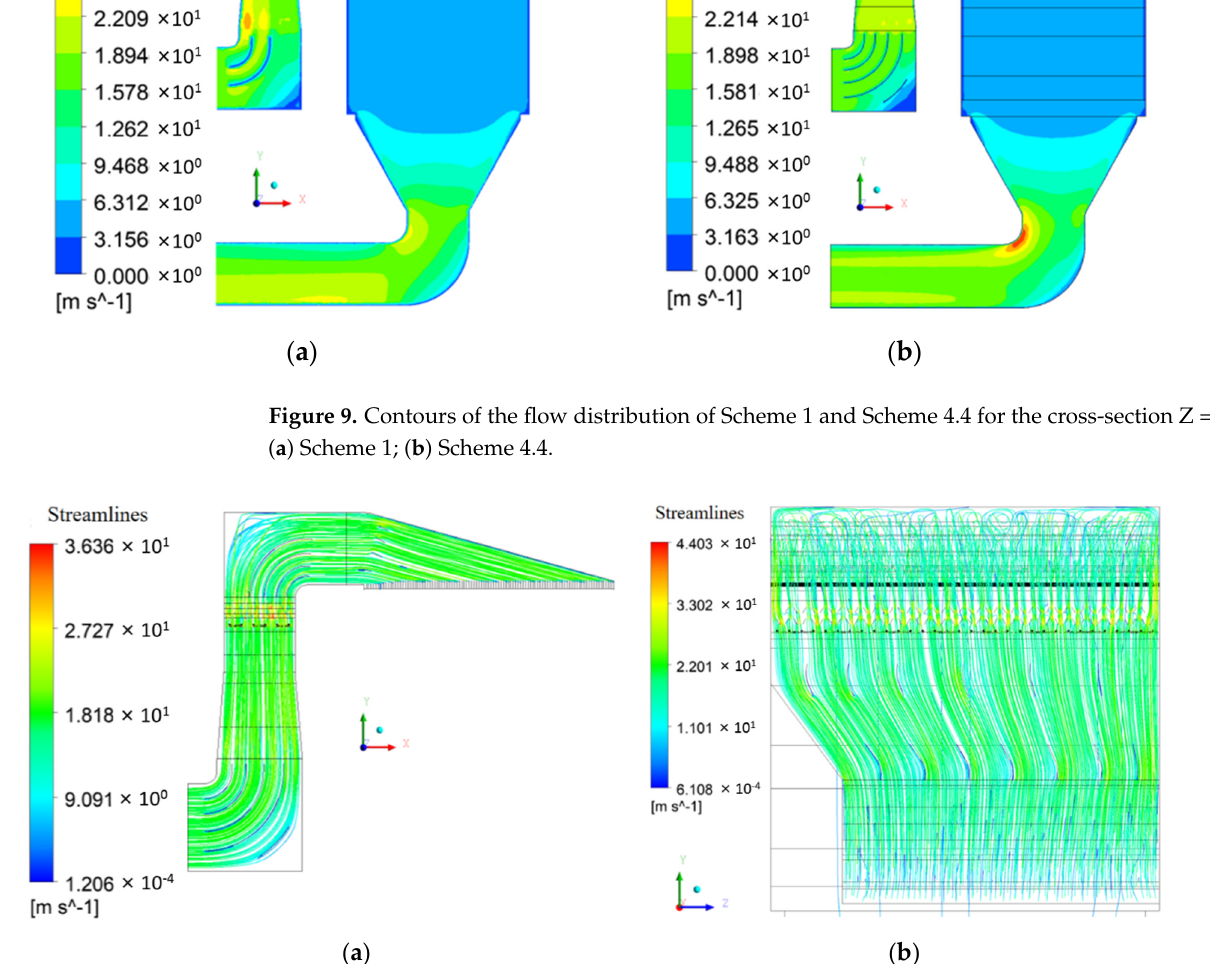
Figure 10. Streamlines and vortices of SCR-DeNOx system for Scheme 4.4: ( a ) view from +Z direction; ( b ) view from − X direction.